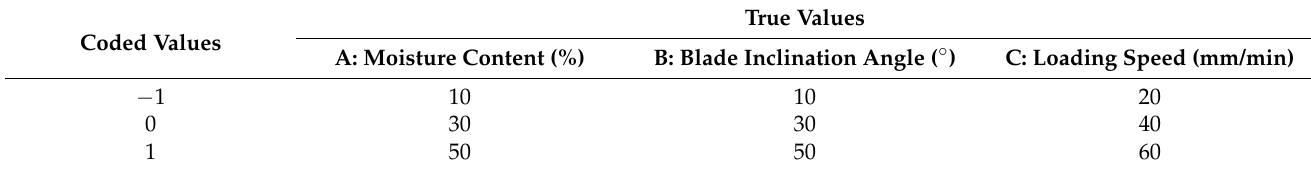
Table 1. Coded values and true values of the test scheme.